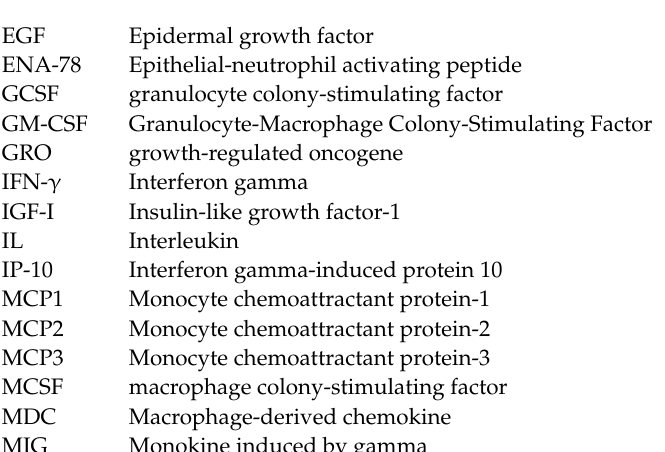
in vitro; Figure S2: Statins effects in MRC5 cells; Figure S3: Effect of statins on cytokines secretion in CaCO2